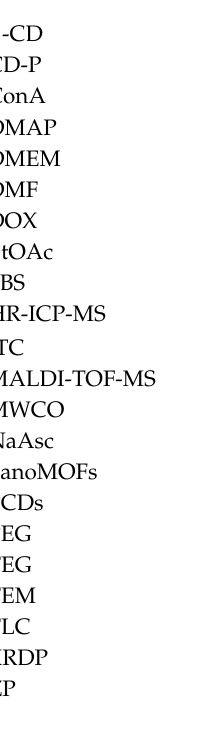
CDCl 3 , 25 ◦ C) for compound 3 , Figure S12: 13 C NMR spectrum (125 MHz, DMSO- d 6 , 80 ◦ C) for compound 5 , Figure S13: 13 C NMR spectrum (125 MHz, DMSO- d 6 , 80 ◦ C) for compound 6 , Figure S14: 13 C NMR spectrum (125 MHz, DMSO- d 6 , 80 ◦ C) for compound 7 , Figure S15: 13 C NMR spectrum (150 MHz, D 2 O, 25 ◦ C) for compound 8 , Figure S16: 13 C NMR spectrum (150 MHz, D 2 O, 25 ◦ C) for compound 9 , Figure S17: 13 C NMR spectrum (150 MHz, D 2 O, 25 ◦ C) for compound 10 , Figure S18: 13 C NMR spectrum (75 MHz, D 2 O, 25 ◦ C) for compound 14 , Figure S19: 13 C NMR spectrum (150 MHz, D 2 O, 25 ◦ C) for compound 15 , Figure S20: 31 P NMR spectrum (242.9 MHz, D 2 O, 25 ◦ C) for compound 8 , Figure S21: 31 P NMR spectrum (242.9 MHz, D 2 O, 25 ◦ C) for compound 9 , Figure S22: 31 P NMR spectrum (242.9 MHz, D 2 O, 25 ◦ C) for compound 10 , Figure S23: 31 P NMR spectrum (242.9 MHz, D 2 O, 25 ◦ C) for compound 16 , Table S1: Determination of the number of phosphate groups for compounds 10 – 12 and 18 , Figure S24: XRPD patterns of uncoated nanoMOFs and nanoMOFs coated with CD-P, 8 – 10 , and 16 , Figure S25: DLS size measurements of uncoated nanoMOFs and nanoMOFs coated with CD-P, 8 - 10 and 16 after 6 h incubation in DMEM cell culture medium complemented with 10% FBS., Figure S26: PCDs derivatives grafting e ffi ciency versus nanoMOFs:PCD mass ratio assayed, Table S2: ITC experiments for the interaction of 8 , 10 in 20 mM phosphate bu ff er (pH 7.2) at 25 ◦ C, and titration of conjugates nanoMOFs@ 8 and nanoMOFs@ 10 with ConA in 10 mM TRIS bu ff er (pH 7.5) at 25 ◦ C, Figure S28: Enthalpy-entropy compensation for the interaction of 8